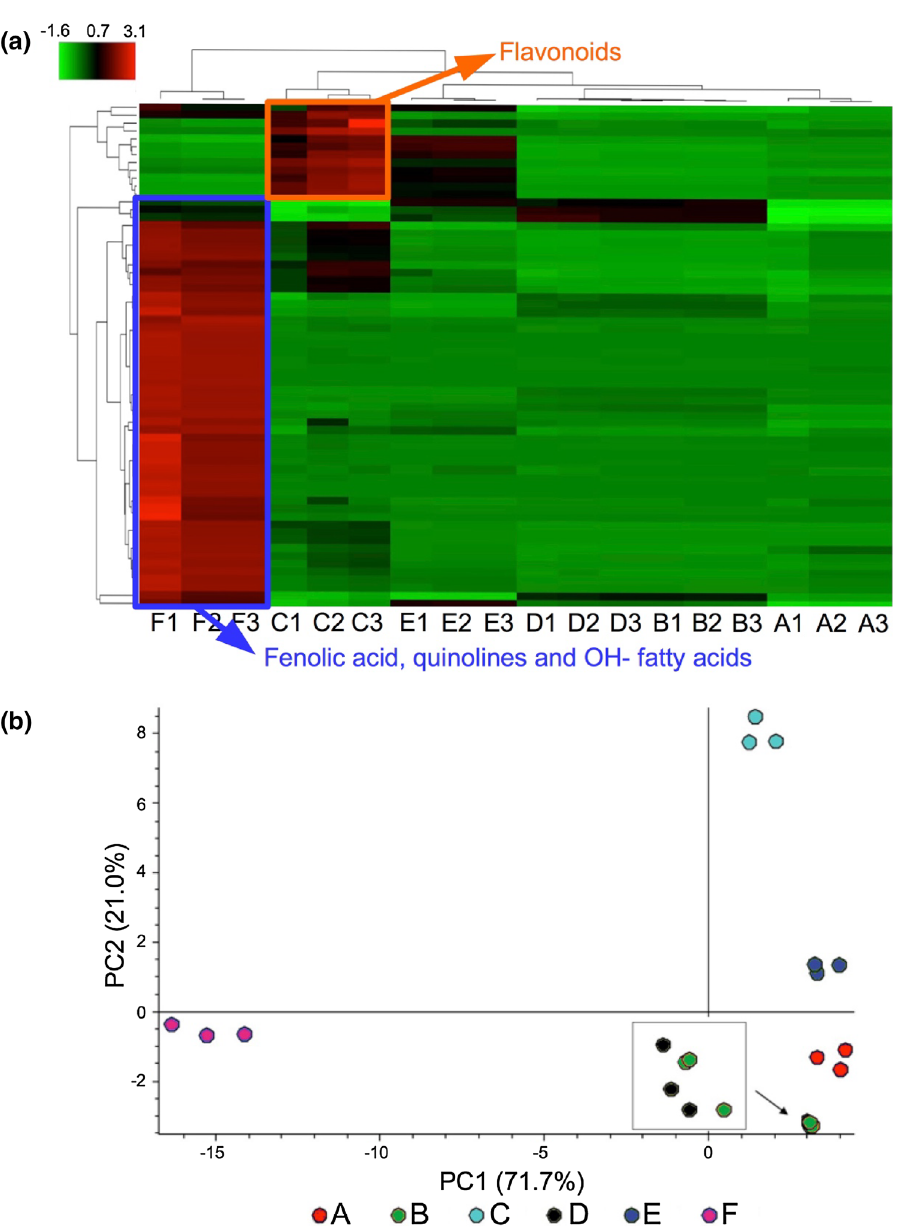
Figure 7. Hierarchical cluster analysis ( a ) and biplot of PCA ( b ) reflecting the differences between compounds revealed in honey samples (red region in heat map for F present prevalently phenolic acid and hydroxy fatty acids profile while the red region for C stands for reach flavonoids fraction). Capital letters indicate the samples and the number the analytical repetitions. Heat-map (cells, exposed to honeys) was generated using R 3.5.2. software 30 .